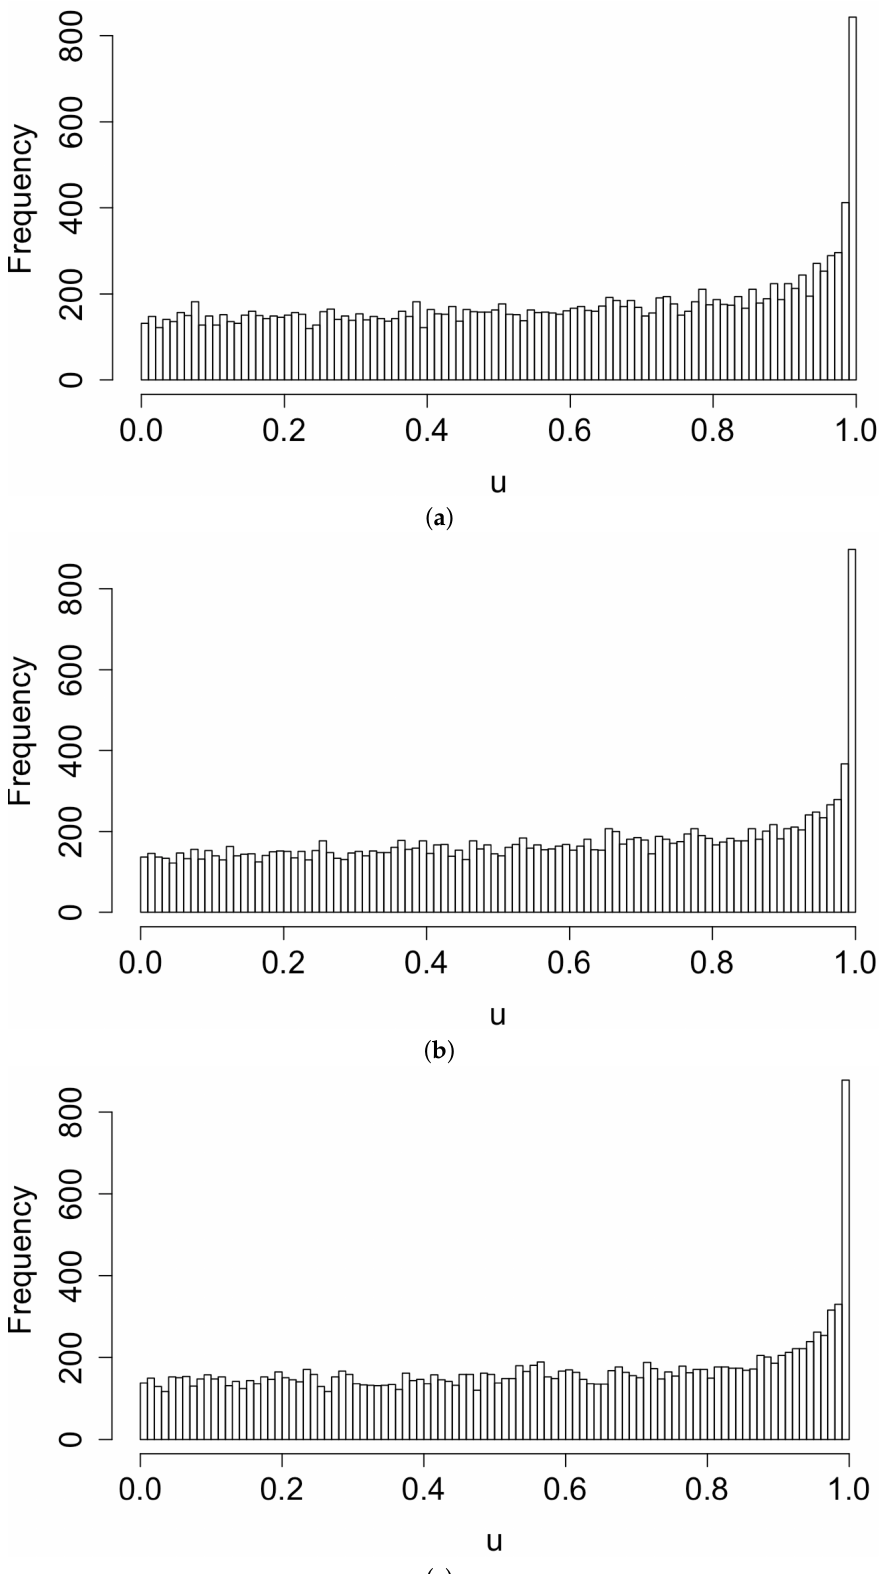
Figure 3. Histogram of standardized interevent times u for ( a ) the Hawkes model with power law triggering, ( b ) the Hawkes model with exponential triggering, and ( c ) the recursive